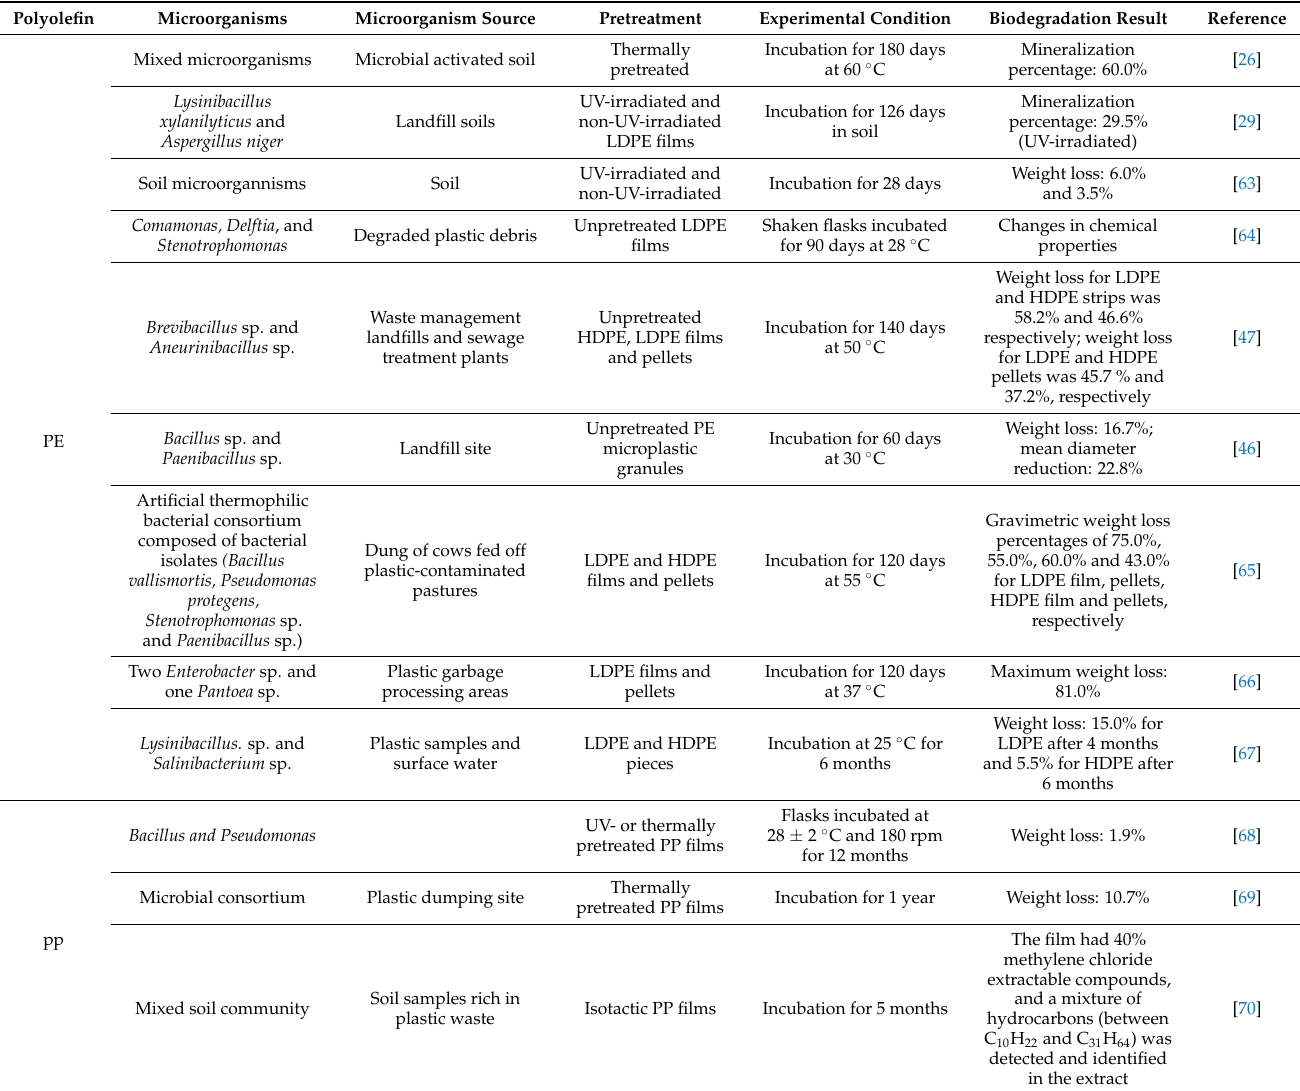
Table 2. Microbial consortia capable of polyolefin